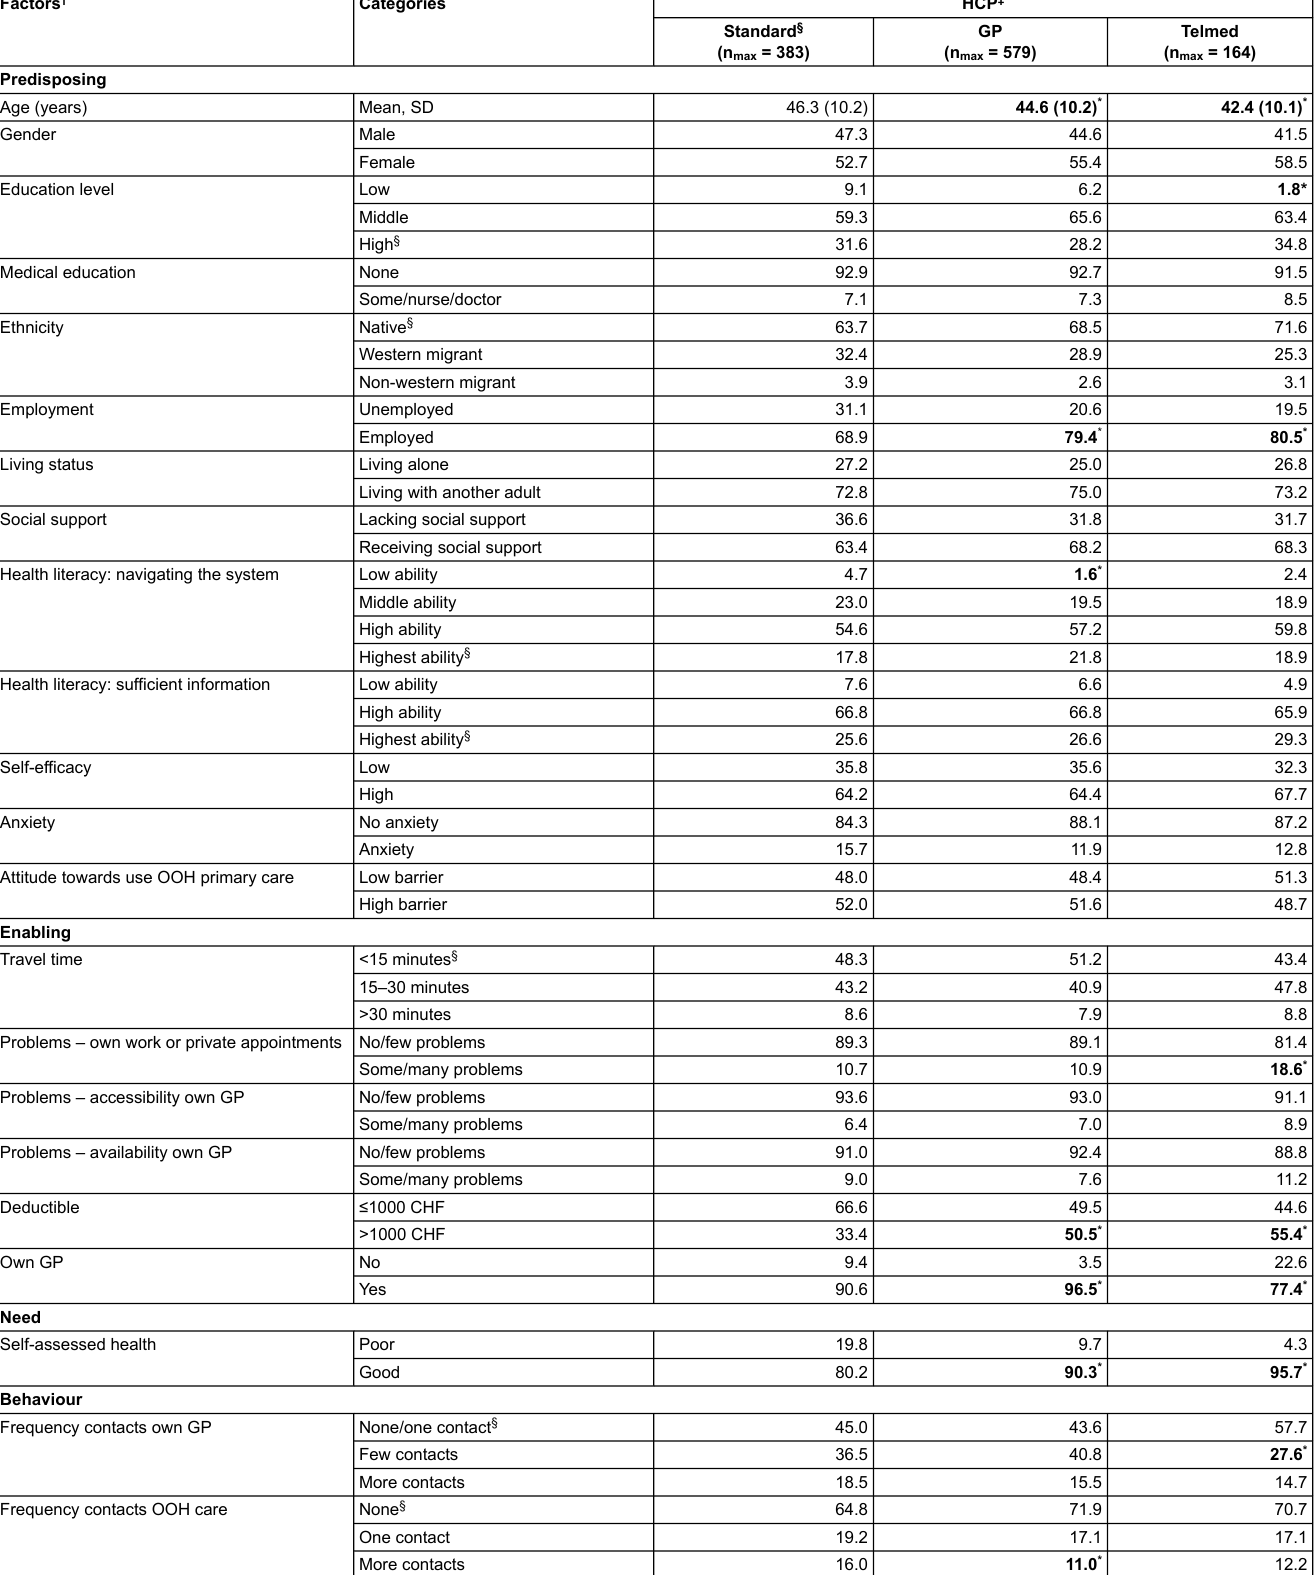
Table 3: Characteristics of the study population, stratified by healthcare plan (HCP). Factors